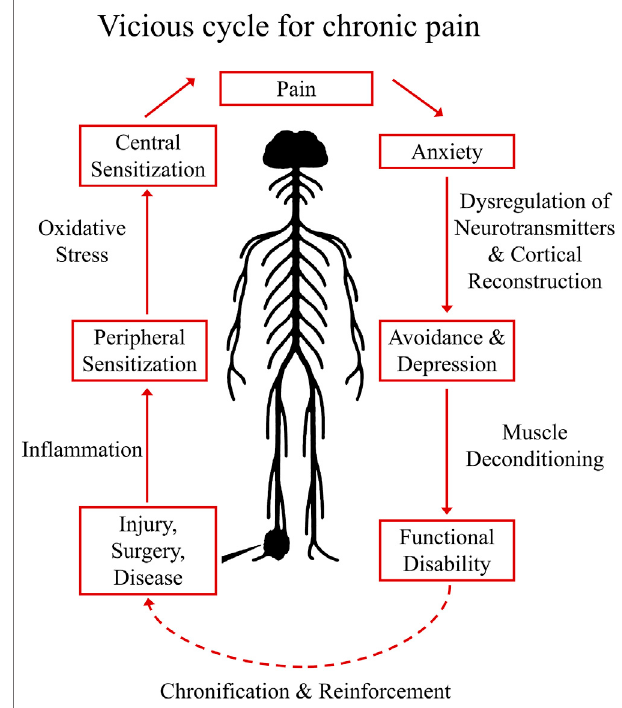
FIGURE 1 | Vicious Cycle for Chronic Pain Establishment. The establishment of chronic pain usually starts with injury, surgery, or diseases that could harm the sensory circuit of the nervous system. When these situations were left to be treated, concomitant local in fl ammation will sensitize peripheral nociceptors (peripheral sensitization), and with accumulated oxidative stress in the CNS, central sensitization (sensitized pain pathway in the spinal cord) may occur, enhancing the pain perception to an intolerable degree (eventually pain symptoms become a disease). In cognitive part, sustained pain could generate anxiety, the pathological sign of chronic pain at this stage may involve dysregulation of neurotransmitters in the CNS and cortical reconstruction, subsequently result in depression and avoidance behaviors. In long term, symptoms of muscle spam and deconditioning could also occur, causing functional disability. In this vicious cycle, the pain syndrome eventually undergoing a chroni fi cation/reinforcement process and becoming increasingly